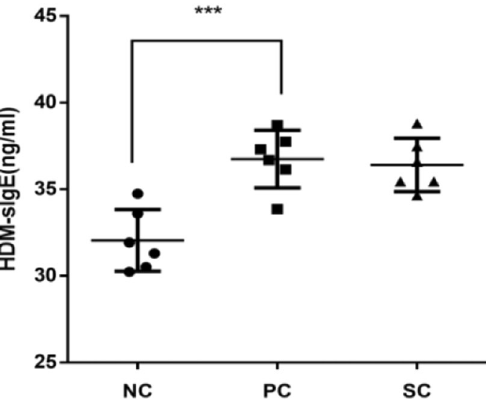
Figure 2. The concentration of HDM-specific IgE in serum was determined by ELISA. ***P < 0.001.